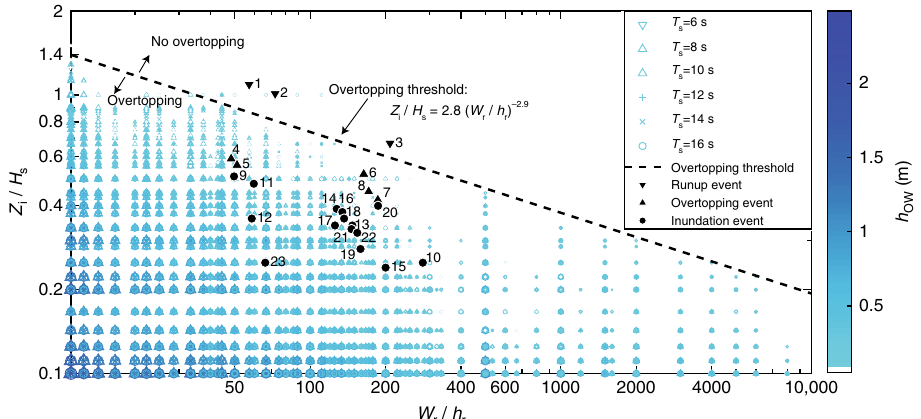
Fig. 2 Threshold conditions for wave-driven fl ooding on atoll islands. Relationship between wave overwash depth, relative reef width ( W r / h r ) and relative island elevation ( Z i / H s ) for all modelled scenarios. Overwash magnitude is indicated by colour (colour bar) and marker size. The dashed black line delineates a threshold where no overtopping occurs (Eq. (1)). Note, there are 31 outliers where marginal overtopping ( h ow < 0.02 m) occurred above the threshold, out of the 3840 unique RRW ( n = 60) and RIE ( n = 64) combination. Black markers represent RRW and RIE combinations associated with documented events where signi fi cant inundation (circle), overtopping at the shoreline (squares) or high runup without overtopping (downward point triangle) occurred on a range of atoll islands (Table